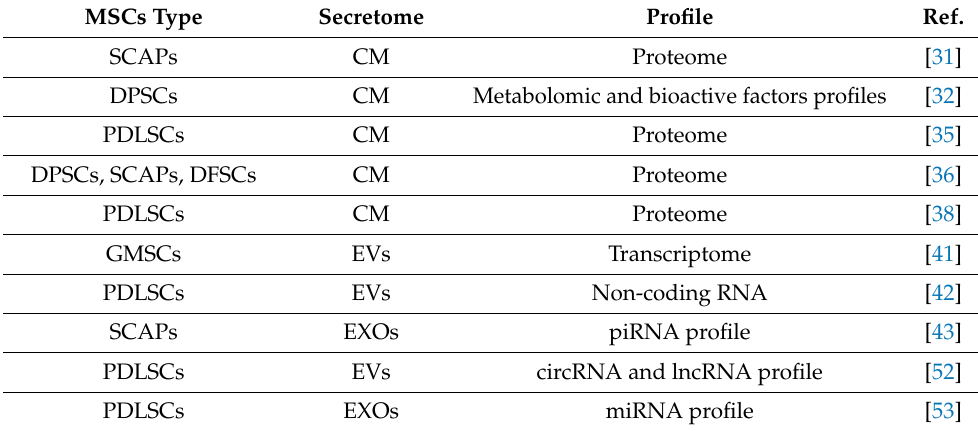
Table 6. Studies analyzing proteome, transcriptome, and non-coding RNA profiles of different dental MSCs. MSCs